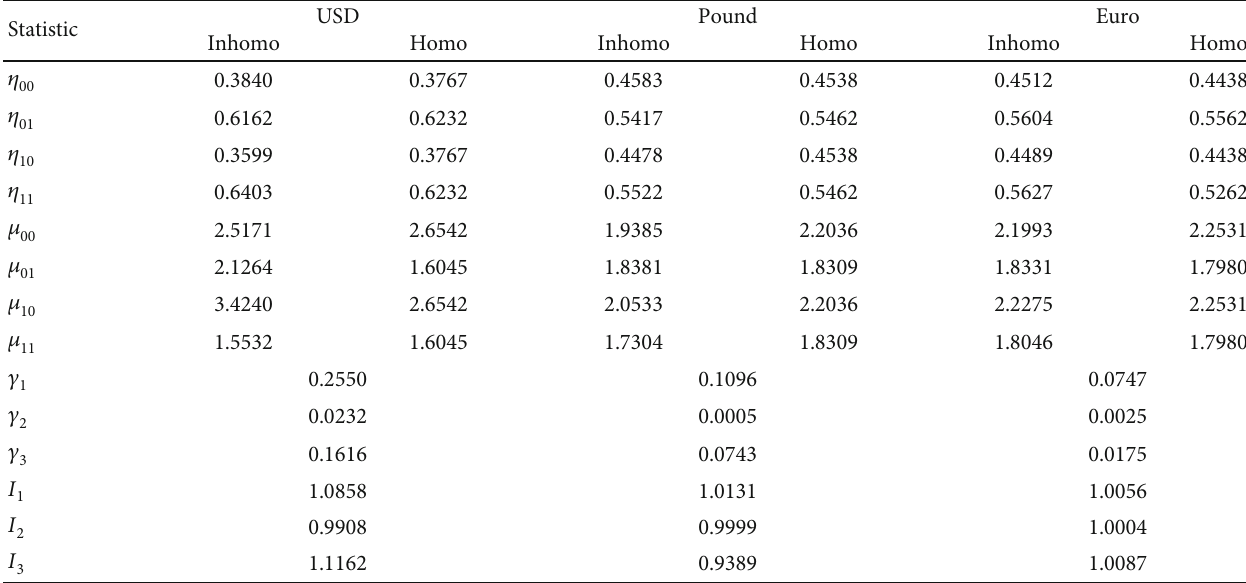
Table 3: Estimates of limiting average of transition probabilities, mean recurrent times, measures, and indices of closeness by currency and type of